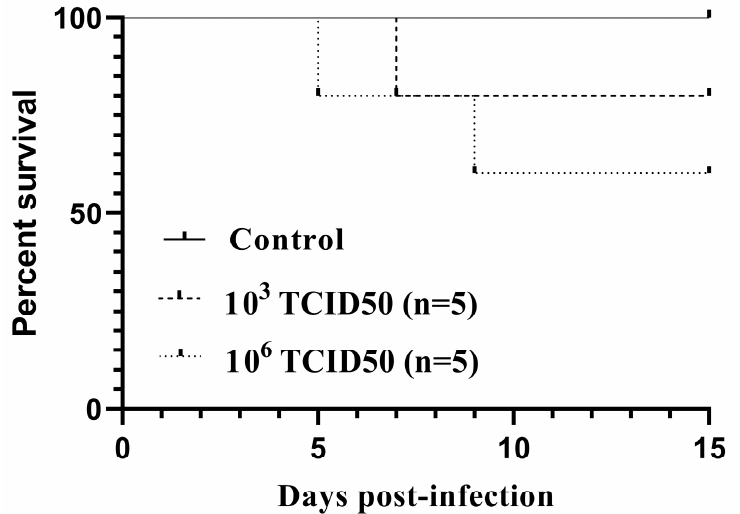
Figure 1. Kaplan–Meier survival curves for canaries intraperitoneally inoculated with 10 3 TCID 50 ( n = 5) or 10 6 TCID 50 ( n = 5) of the Usutu virus.